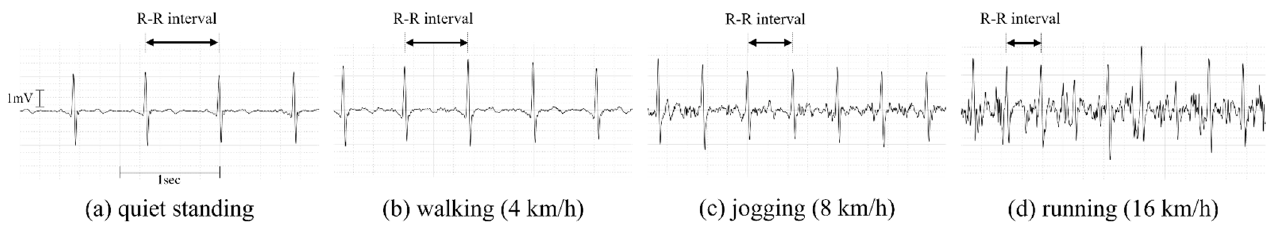
Figure 2. ECG waveforms recorded by the sportswear-type wearable: ( a ) at rest (quiet standing); ( b ) walking; ( c ) jogging; ( d ) running.